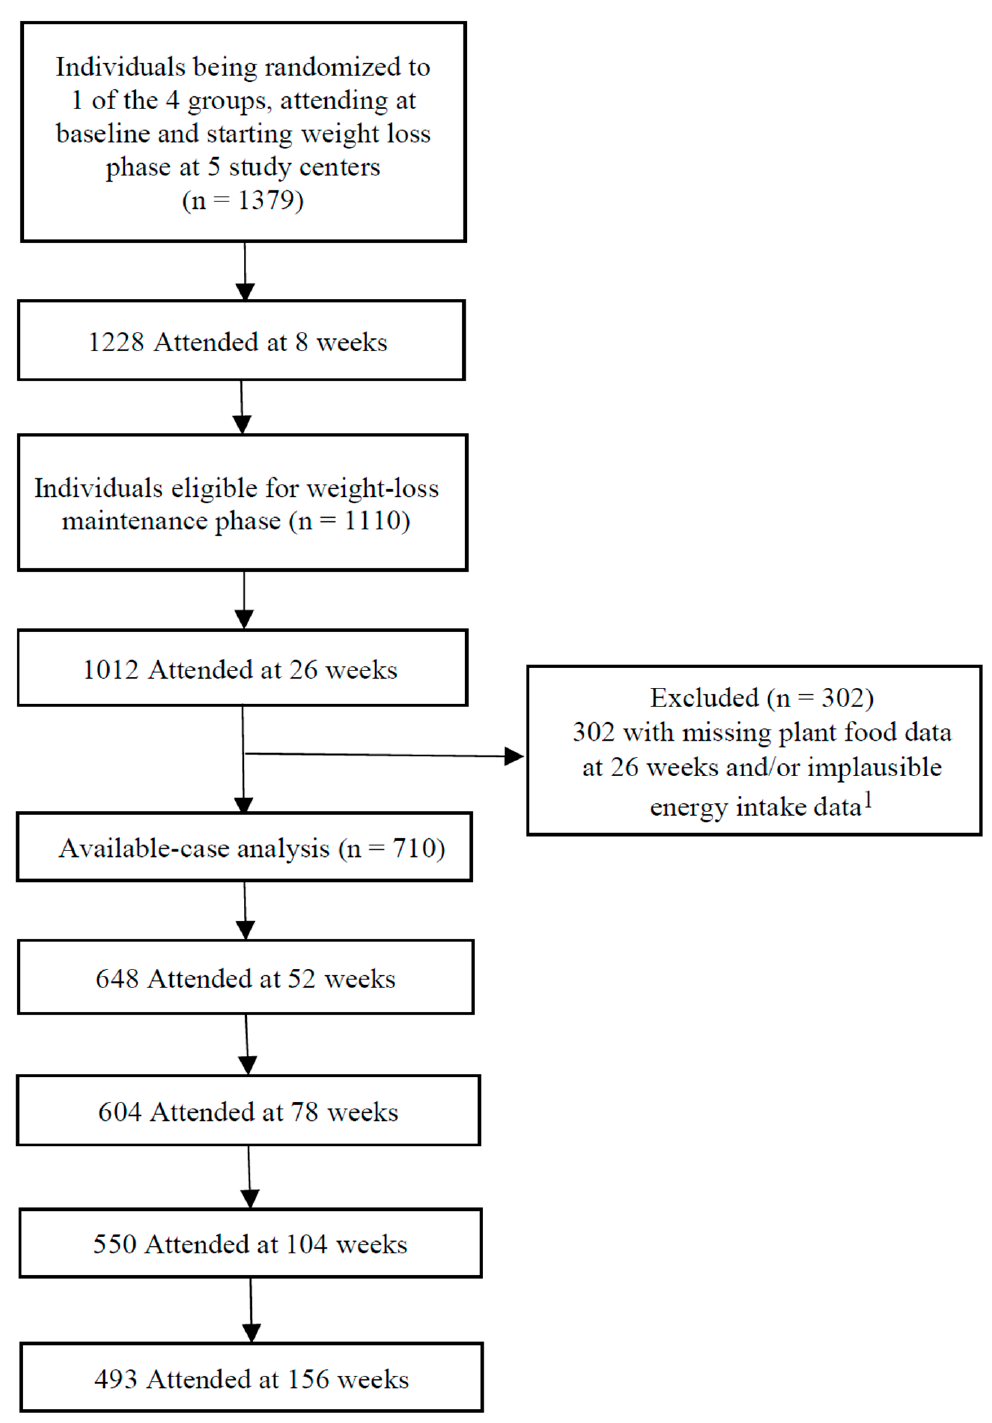
Figure 1. Participant flow diagram. 1 Individuals with missing plant food data at 26 weeks and/or implausible energy intake data (<2520 or >14,700 kJ · day − 1 for women and <3360 or >17,640 kJ · day − 1 for men) were excluded. Table 2. Characteristics of participants at baseline (0 weeks), the start of weight-loss maintenance (8 weeks), or 26 weeks.